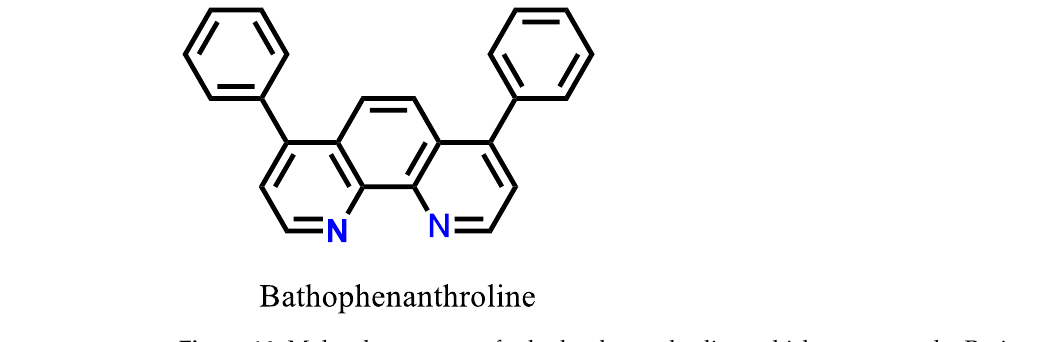
Figure 16. Molecular structure for bathophenanthroline, which reports to the Resins and Toluene asphaltene fraction (1:1).